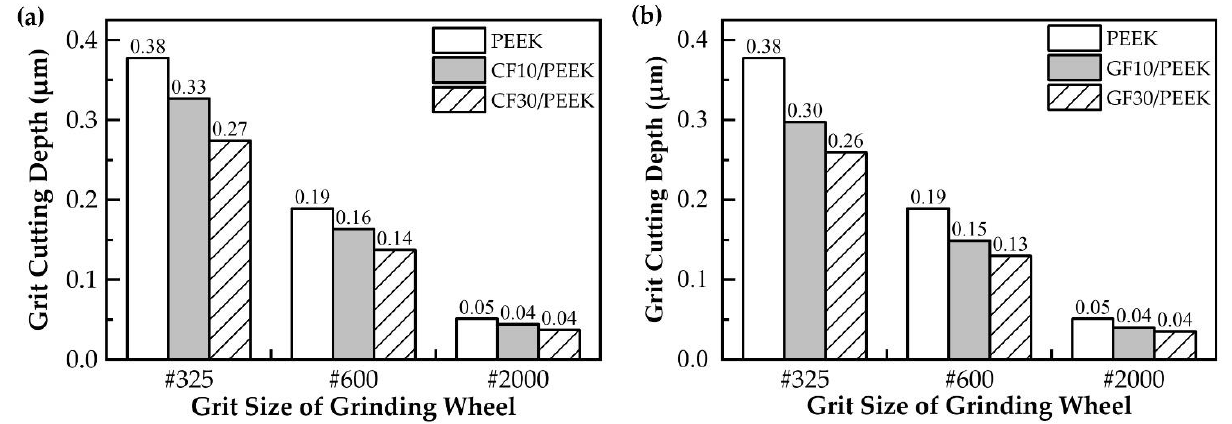
Figure 12. Comparison of grit cutting depth for different fiber-reinforced PEEK: ( a ) carbon-fiber- reinforced PEEK; ( b ) glass-fiber-reinforced PEEK.